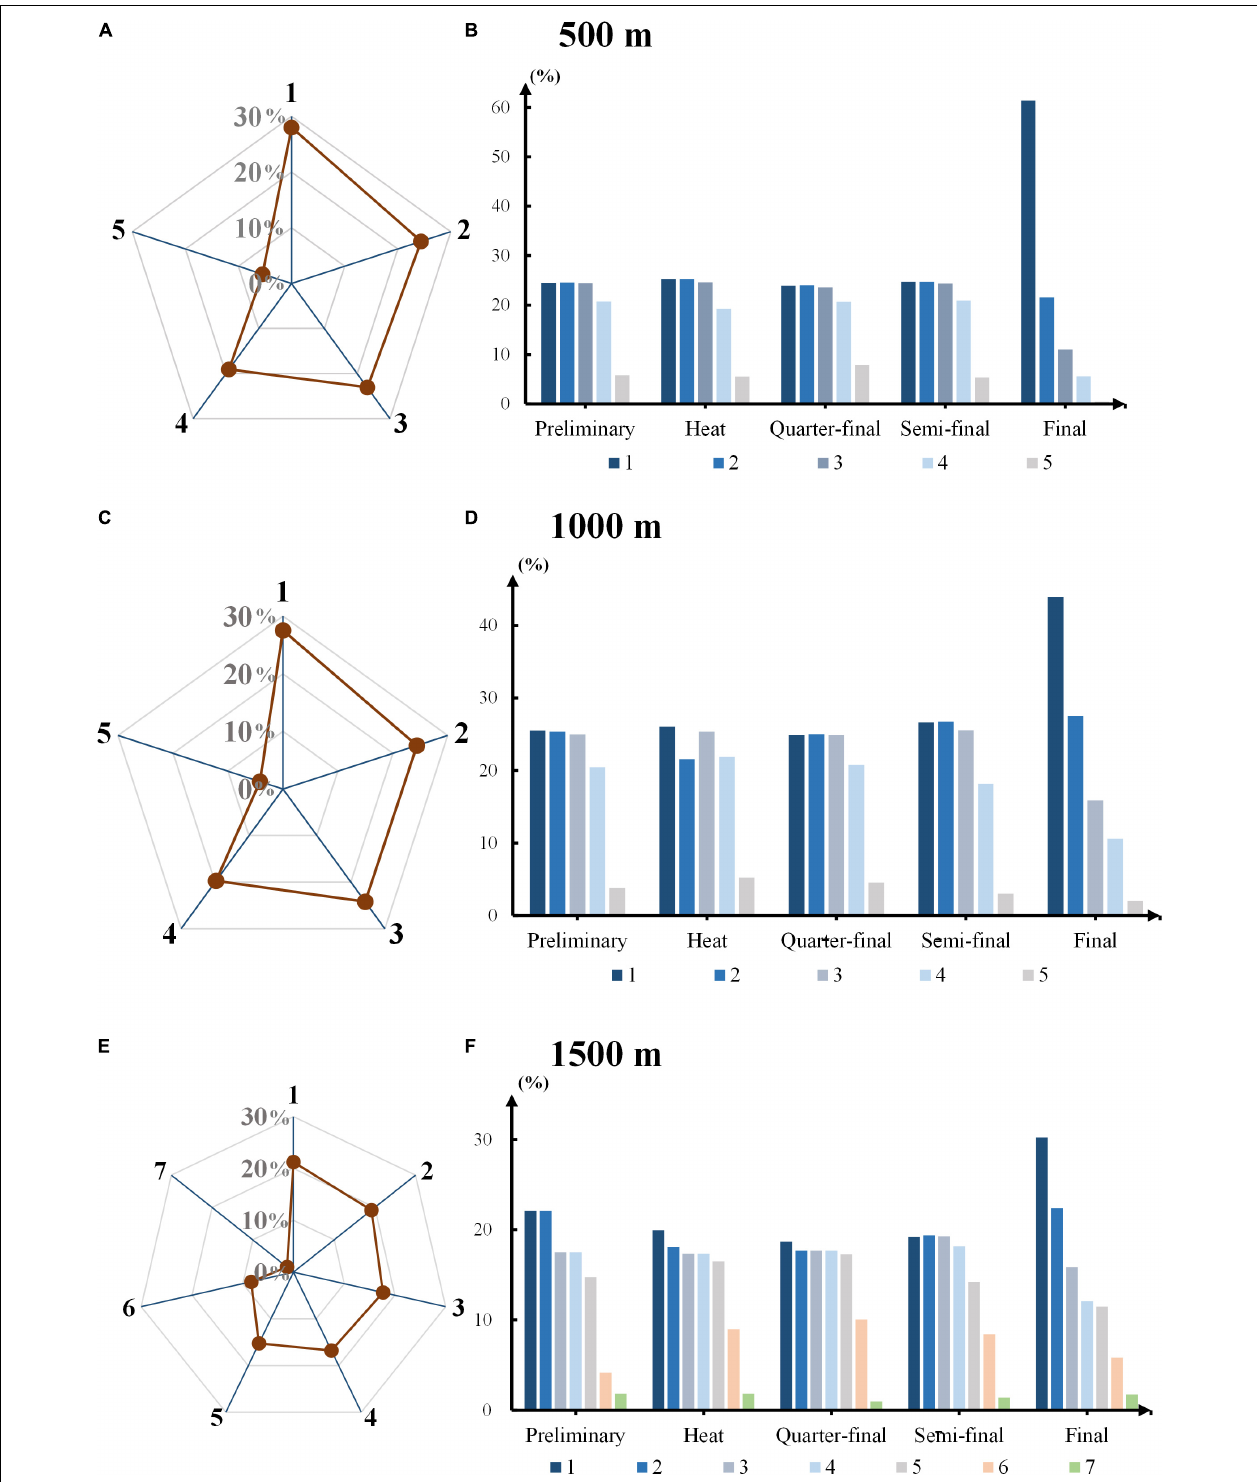
FIGURE 1 | Starting position distribution for round winners. (A,C,E) The overall starting position distribution of the winners in different race distances in 500, 1000, and 1500 m competitions respectively. The axis labels on radar charts represent starting lanes. (B,D,F) Separate starting position distributions of each round ranging from preliminary to final in 500, 1000, and 1500 m